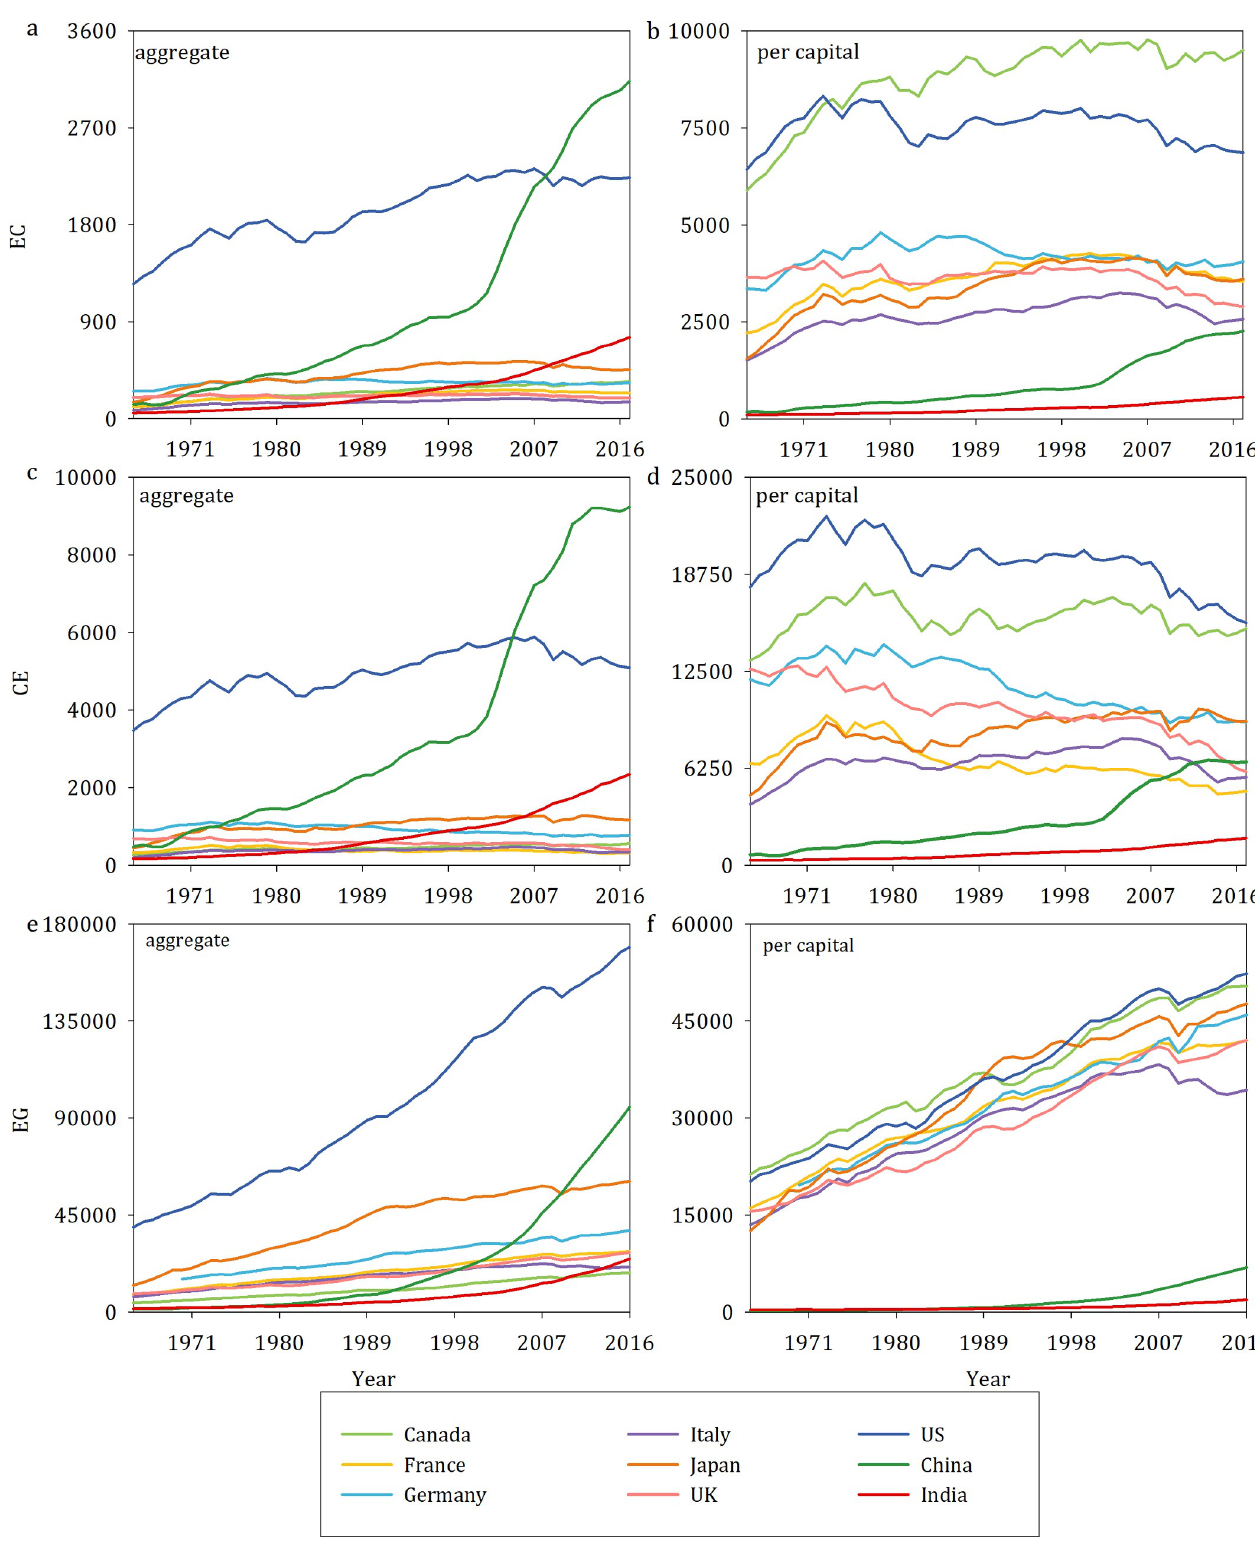
Fig 1. Energy consumption, carbon emissions and economic growth in nine countries. Aggregate energy consumption (a) and per capita energy consumption (b), aggregate carbon emissions (c) and per capita carbon emissions (d), aggregate real GDP (e) and per capita real GDP (f).